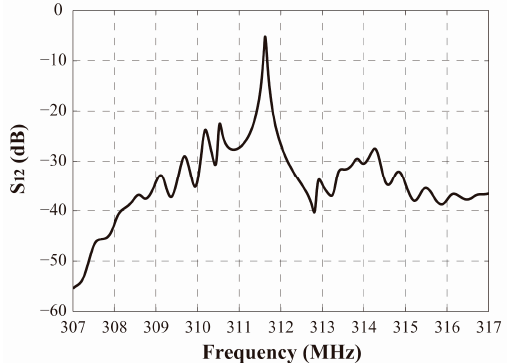
Figure 10. Frequency response of the SAW resonator.